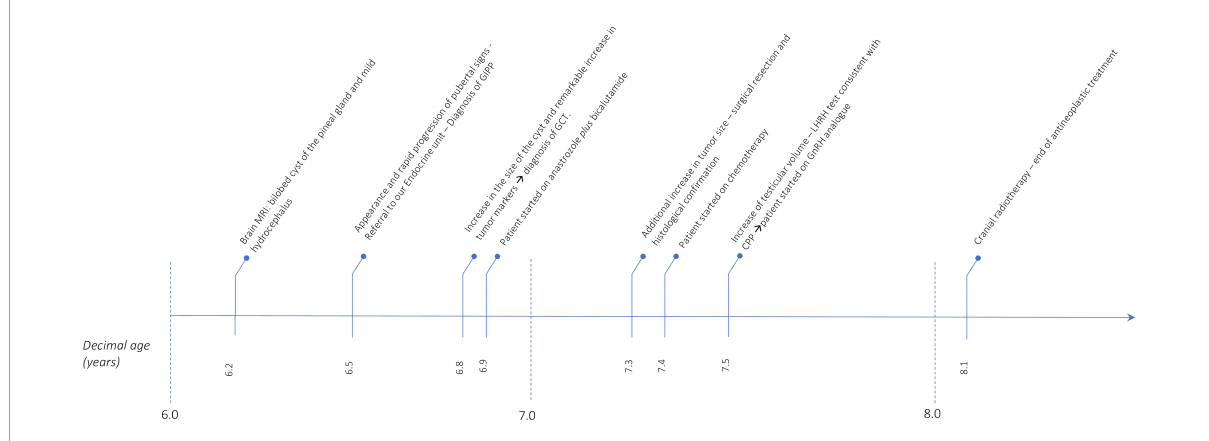
FIGURE4 Timeline that summarizes the events reported. MRI, magnetic resonance imaging; GIPP, GnRH independent precocious puberty; GCT, germ cell tumor; CPP, central precocious